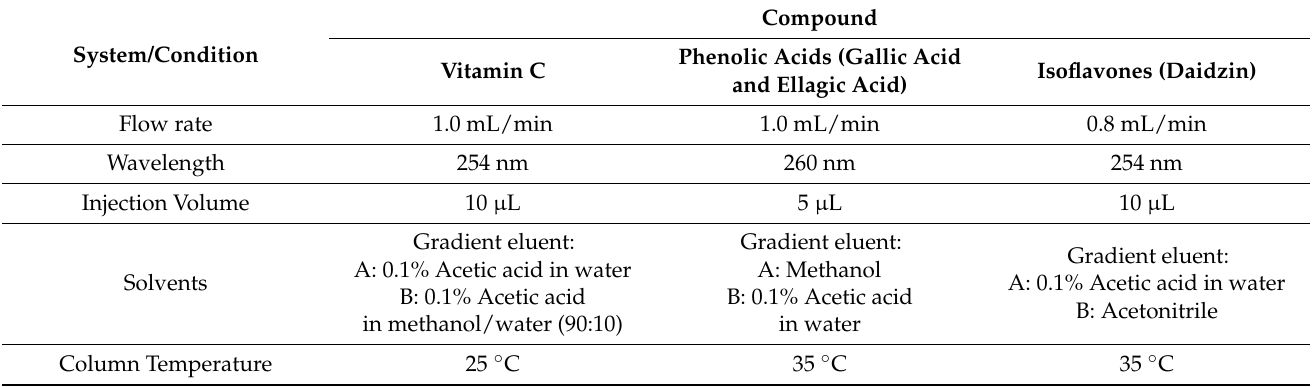
Table 1. HPLC system and condition for analysis of vitamin C, phenolic acids, and isoflavones. Compound System/Condition Phenolic Acids (Gallic Acid Vitamin C Isoflavones (Daidzin) and Ellagic Acid) Flow rate 1.0 mL/min Injection